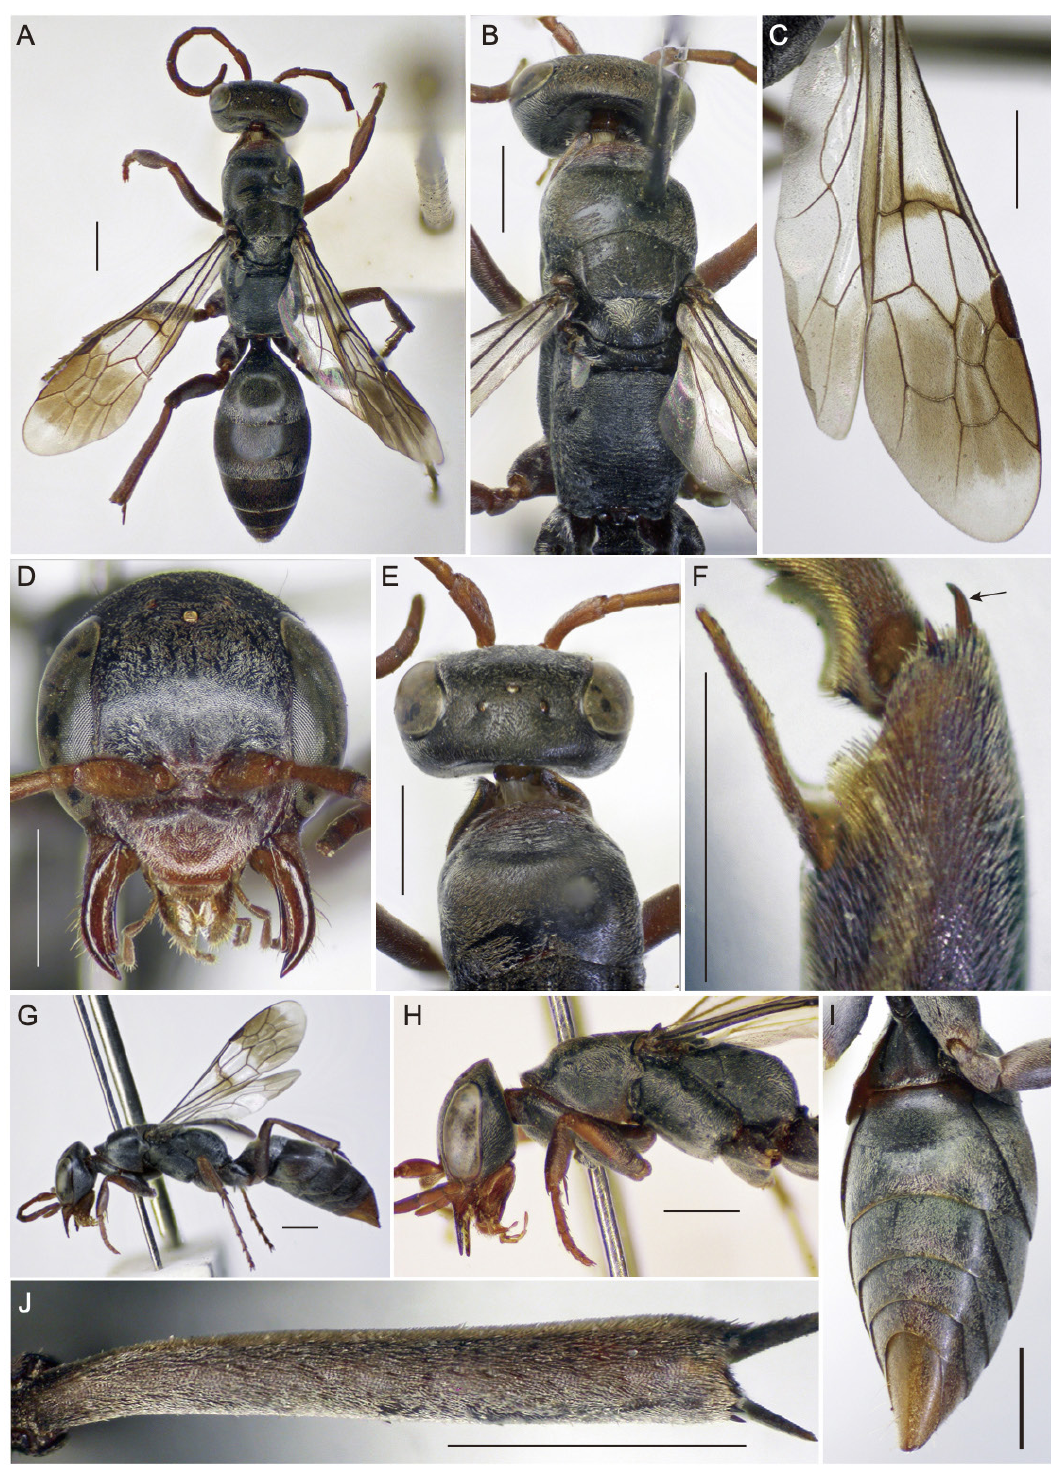
Fig. 7. Paraclavelia arabiae Shimizu sp. nov., holotype, ♀ (NHMUK). A . Whole body, dorsal view. B . Head and mesosoma, dorsal view. C . Right wings. D . Head, anterior view. E . Head and pronotum, dorsal view. F . Apical part of right fore tibia, mesial view, arrow indicates apicomesial spine on fore tibia. G . Whole body, lateral view. H . Head and mesosoma, lateral view. I . Metasoma, ventrolateral view. J . Right hind tibia, dorsal view. Scale bars: A–E, G–J = 1 mm; F = 0.5